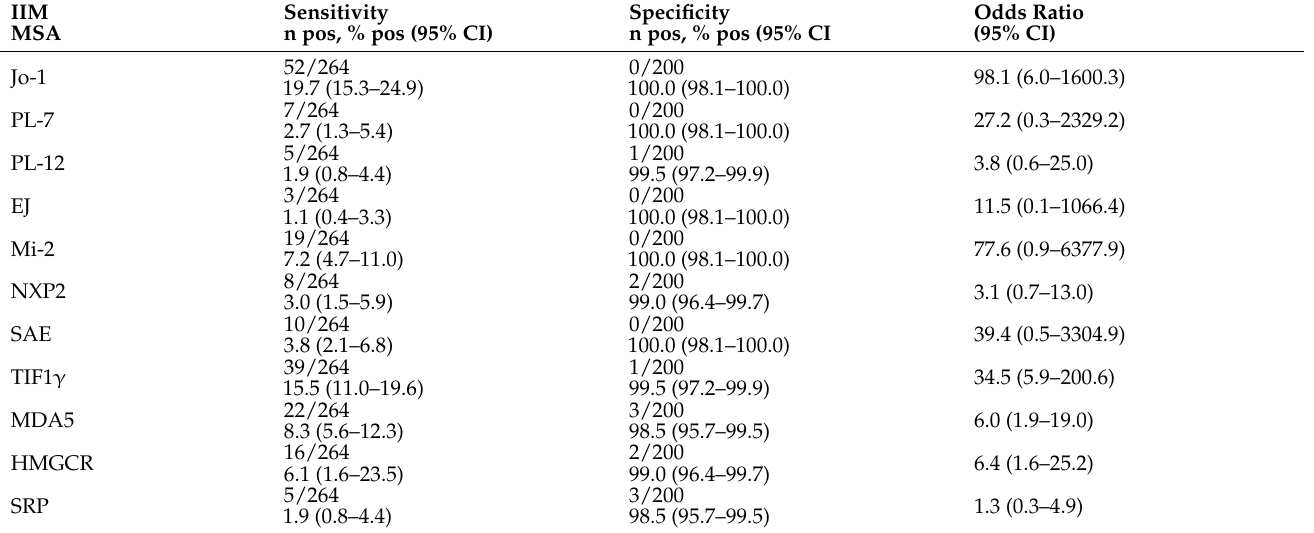
Table 1. Prevalence of autoantibodies in different disease